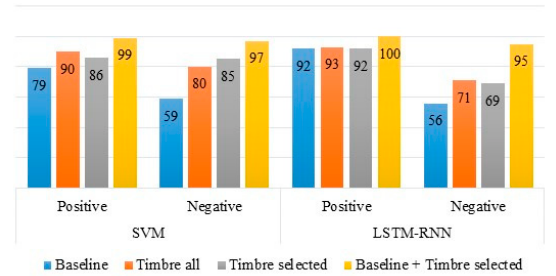
Figure 4. Recognition rates of positive and negative emotions on baseline, timbre all, timbre selected, and the combination of baseline and timbre selected acoustic feature sets for EMO-DB. Appl. Sci. 2019 , 9 , x FOR PEER REVIEW